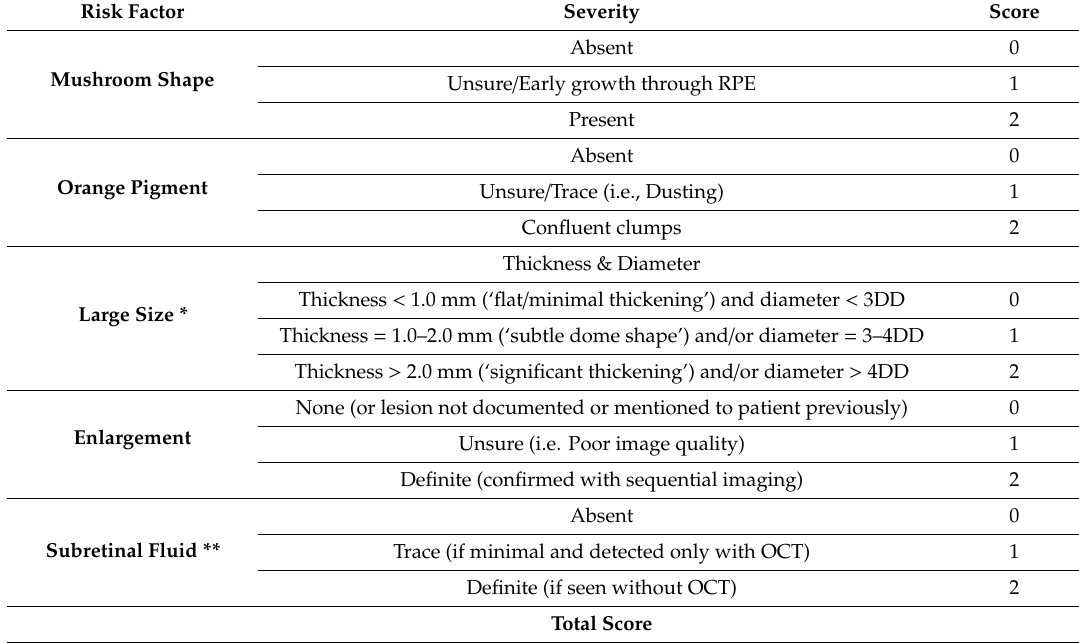
Table 1. MOLES scoring criteria.